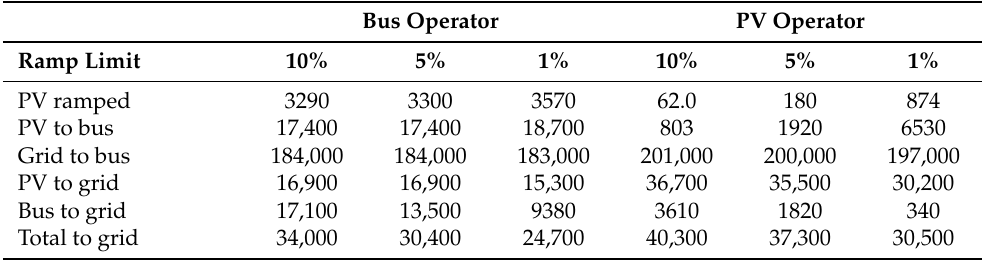
Table 1. Amount of PV ramped, PV energy fed to buses, grid energy fed to buses, PV energy fed to grid, energy from BEB batteries fed to grid, and total energy fed to the grid (all in kWh) for both objectives and three different ramp rate limits for one